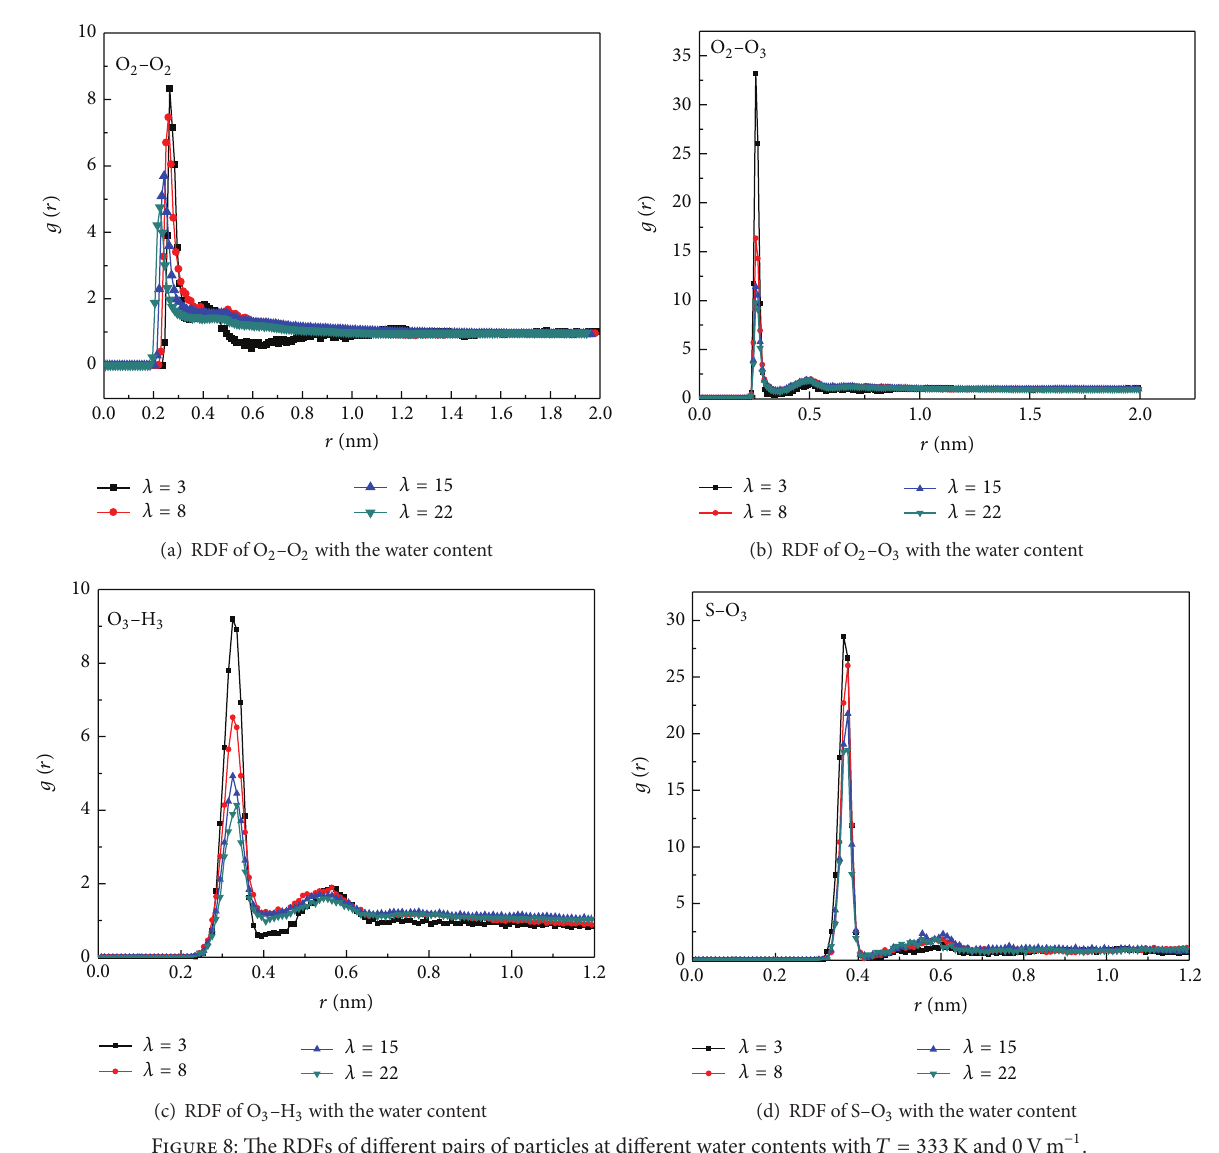
Figure 8: The RDFs of different pairs of particles at different water contents with 𝑇 = 333 K and 0Vm −1 .